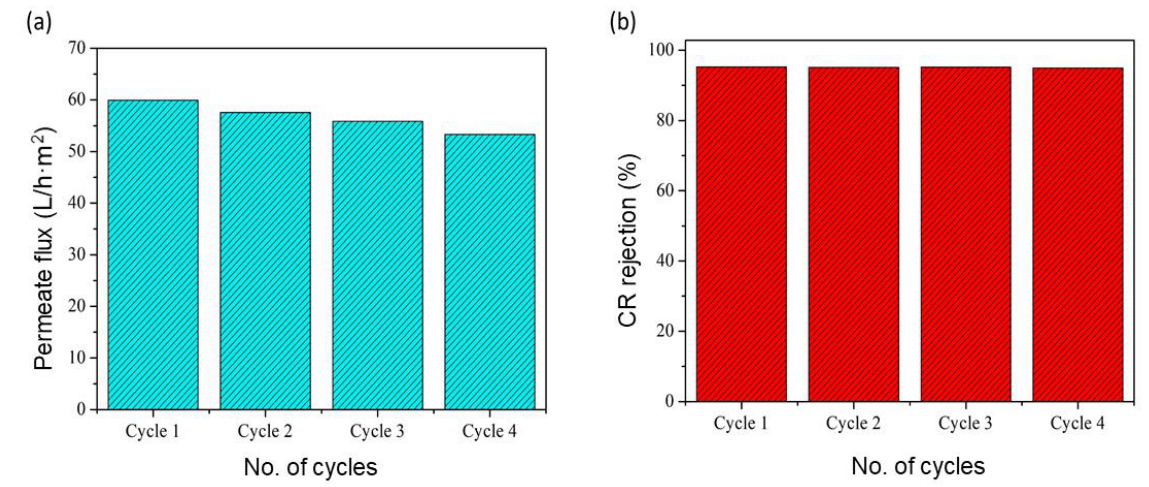
Figure 13. Recyclability studies of GO/phosphate membrane: ( a ) permeate flux and ( b ) rejection rate of CR dye for four cycles.